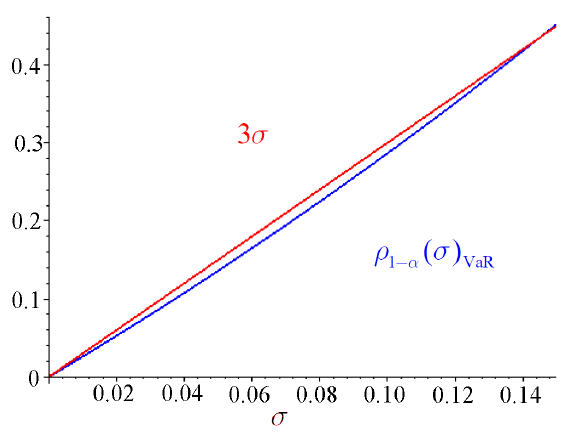
Figure 1: Plot of the Non-Life SCR volume factor ρ 1− α ( σ ) VaR vs. its simplification 3 σ .